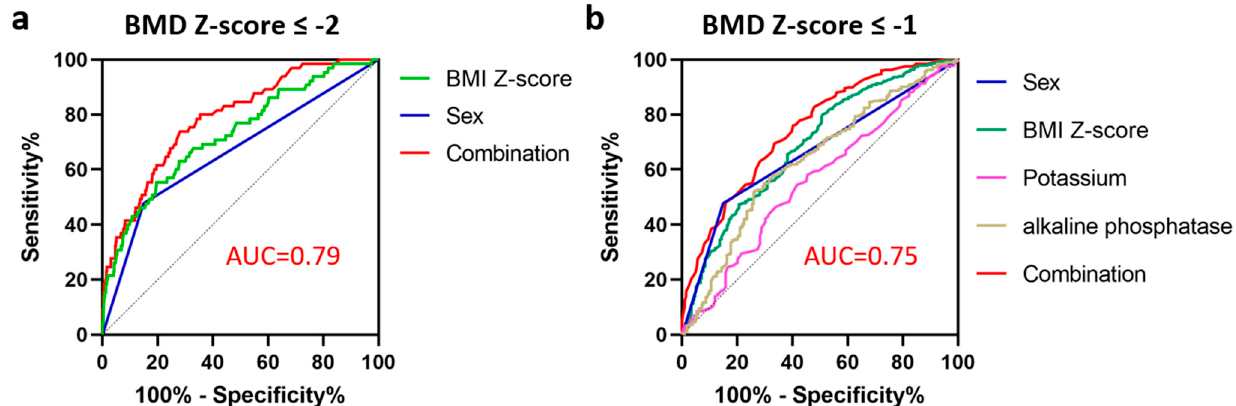
Figure 2. Receiver operating characteristic (ROC) curves of individual parameters or combination of